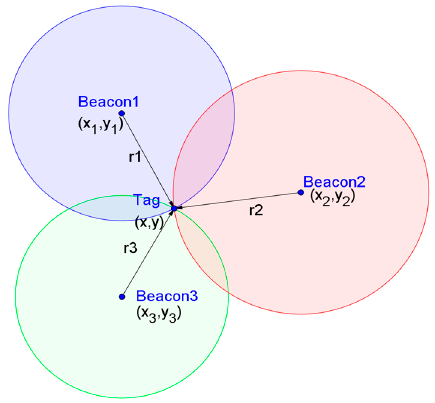
Figure 2. Position estimation by trilateration without measurement error.